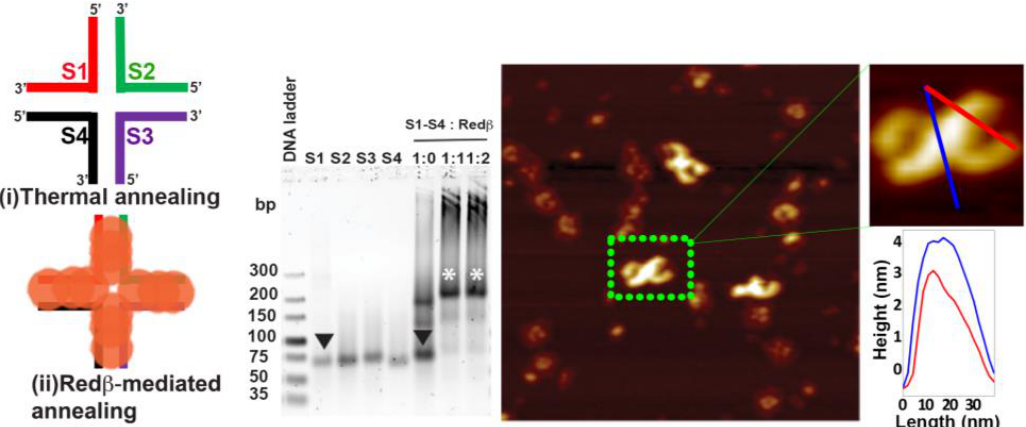
Figure 3. The schematic structures show the 66 mer HJ junction design assembled by thermal ( i ) and Red β -mediated ( ii ) annealing. The sodium borate agarose gel analysis shows the saturation concentration ratio of Red β to ssDNA. The downward-facing arrowheads (black) in the gel image indicate the free ssDNA, while the white asterisks indicate the HJ structures. The AFM image depicts the resulting Red β -mediated HJ assemblies. The height profiles were taken along the lines indicated in the zoom. The AFM image has a size of 300 × 300 nm 2 and a height scale of 4